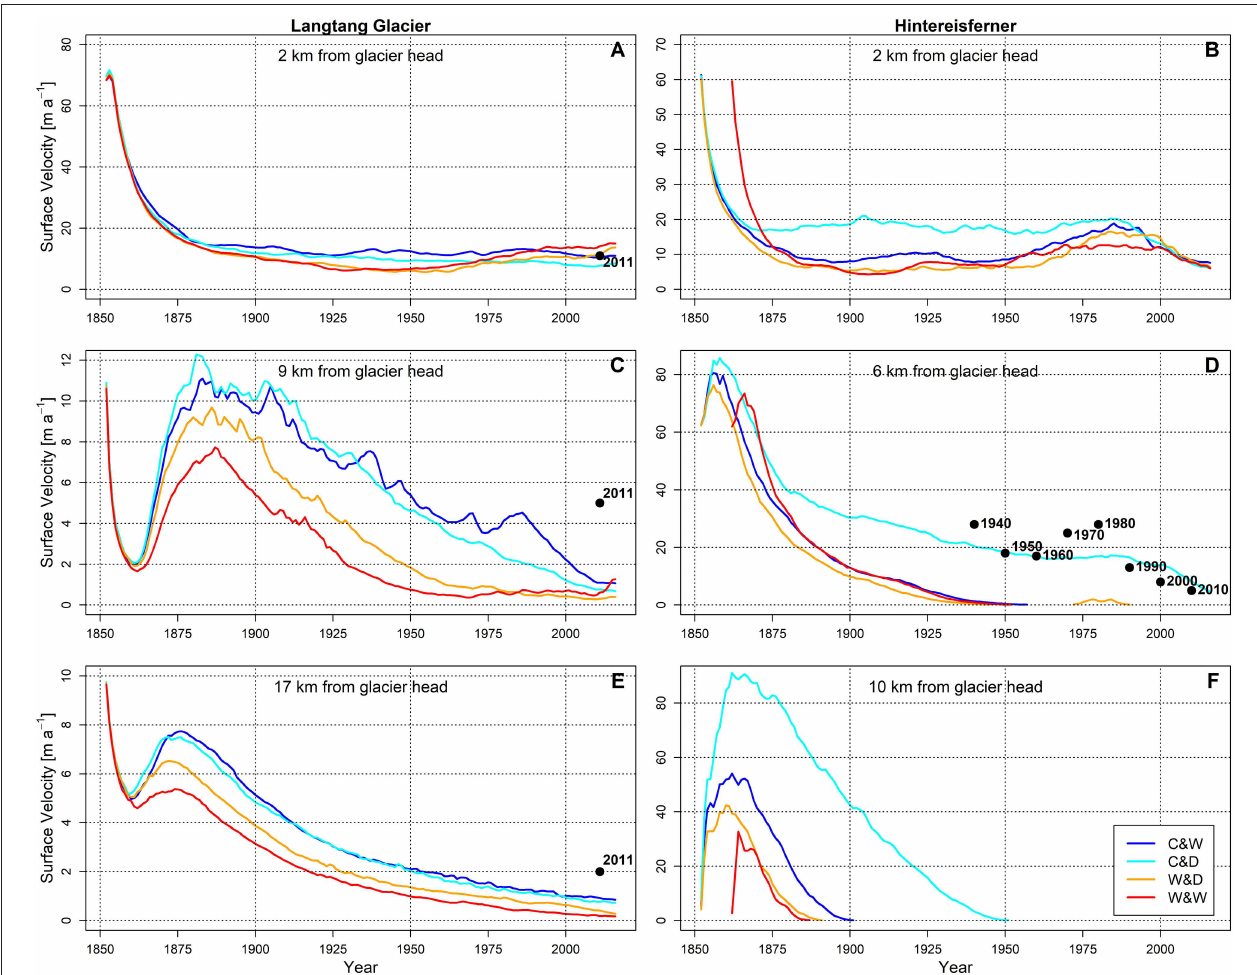
FIGURE 5 | Modeled changes in surface velocity at three different transects along the Langtang Glacier (A,C,E) and Hintereisferner (B,D,F) for four different historical climate change simulations (CW: cold and wet; CD: cold and dry; WW: warm and wet; WD: warm and dry). The locations of the three transects are given in Figure 6 . The black points denote the observed velocities at Langtang Glacier (2011) and Hintereisferner (1940, 1950, 1960, 1970, 1980, 1990, 2000; Stocker-Waldhuber et al., 2019